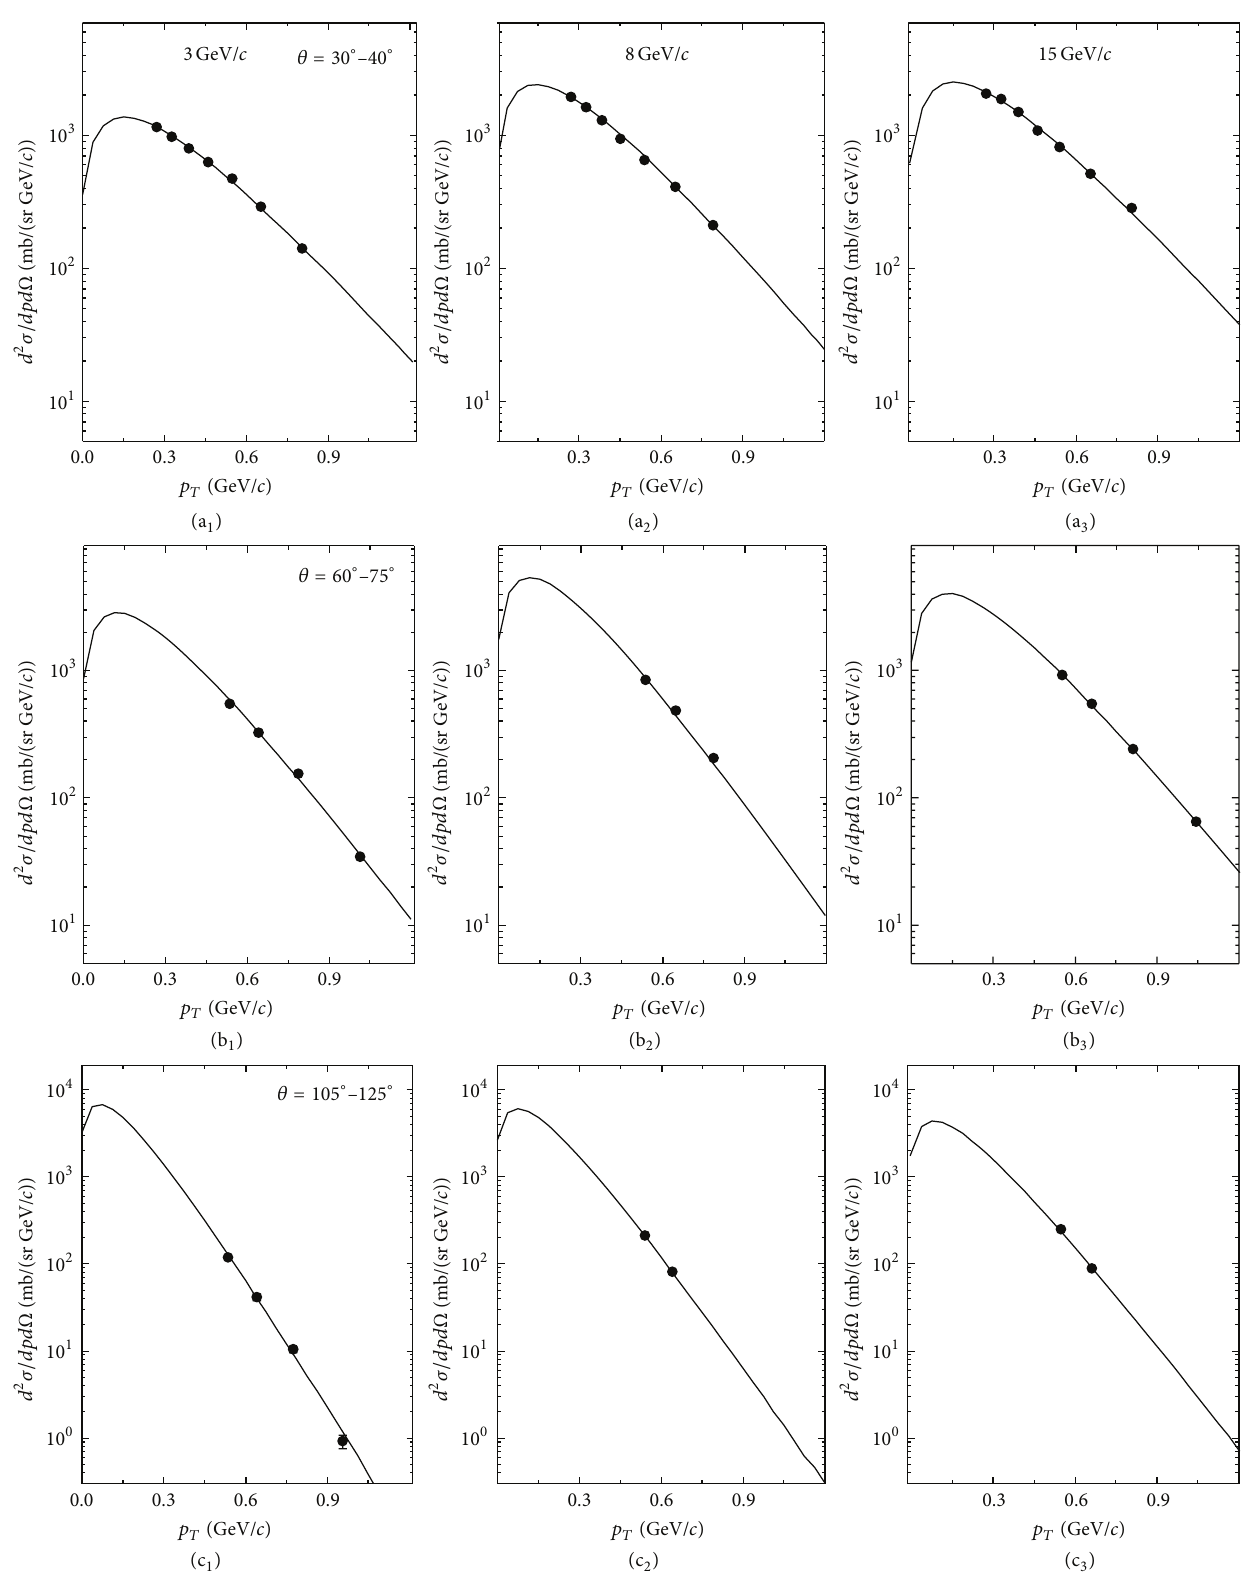
Figure 4: Transverse momentum of protons produced in 𝑝 + Pb collisions at 3, 8, and 15GeV/ c . The angular bins are 30 ∘ –40 ∘ , 60 ∘ –75 ∘ , and 105 ∘ –125 ∘ , respectively. The circles indicate the experimental data [9] and the curves indicate the results of the